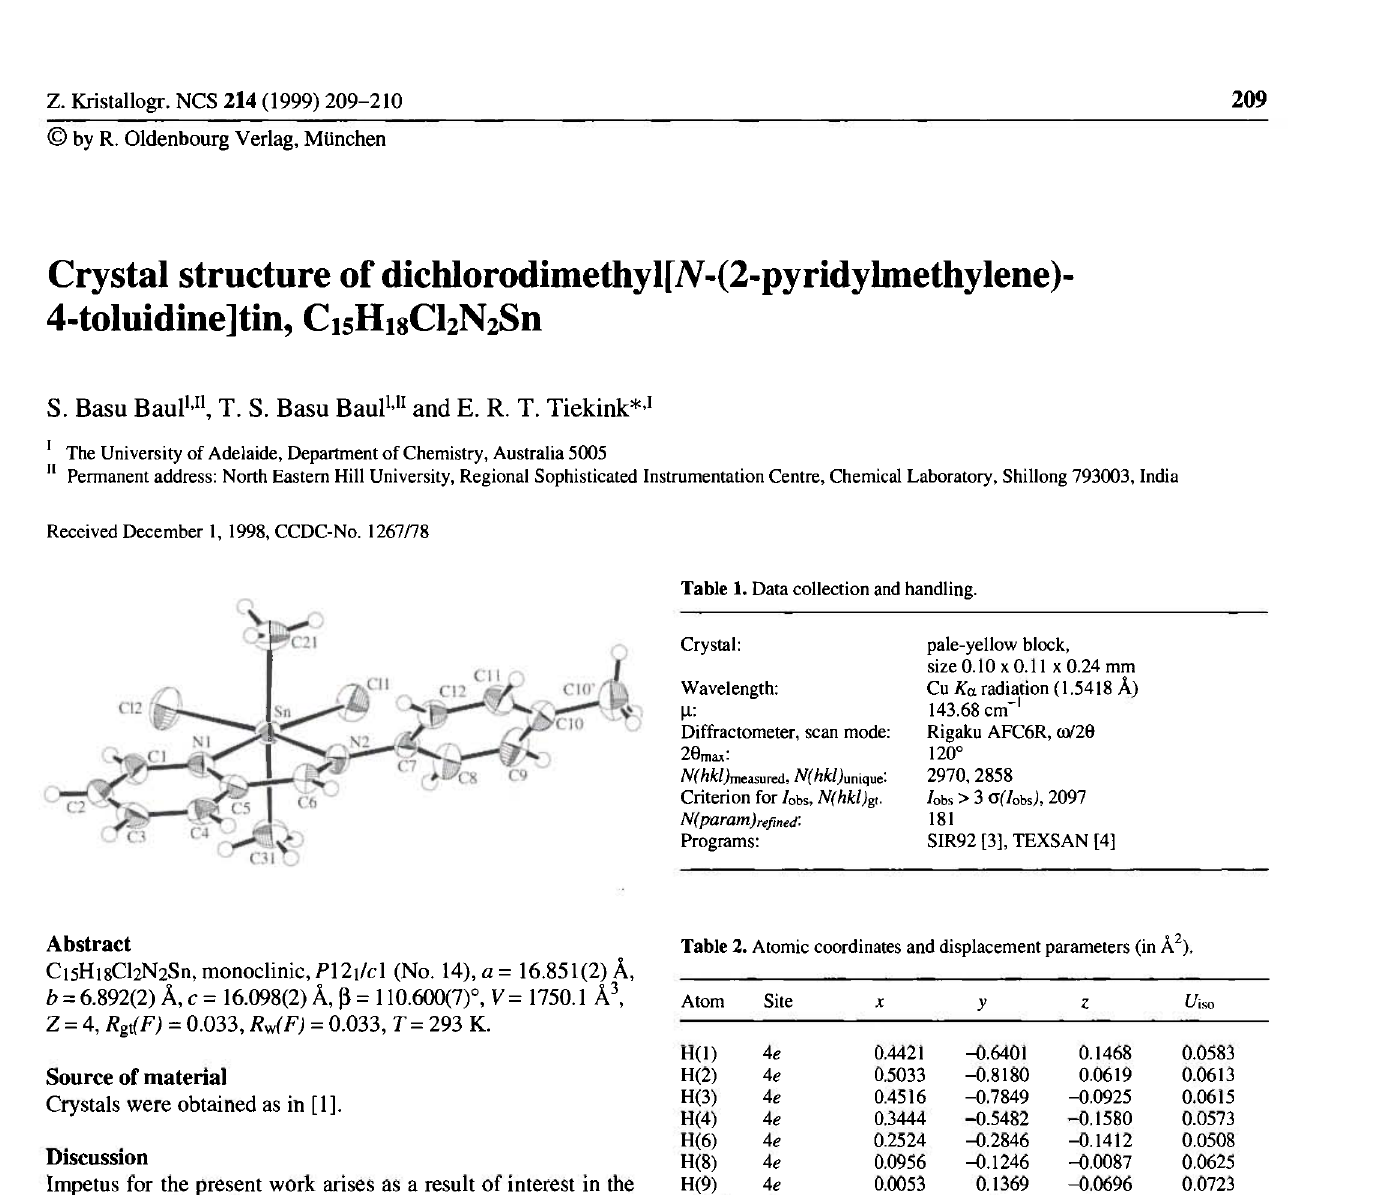
Table 2. Atomic coordinates and displacement parameters (in A 2 ).